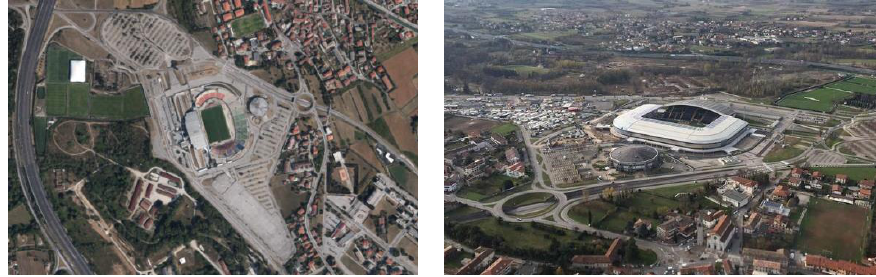
Figure 2. Dacia Arena, Udine, before ( left ) and after ( right ) the restoration.